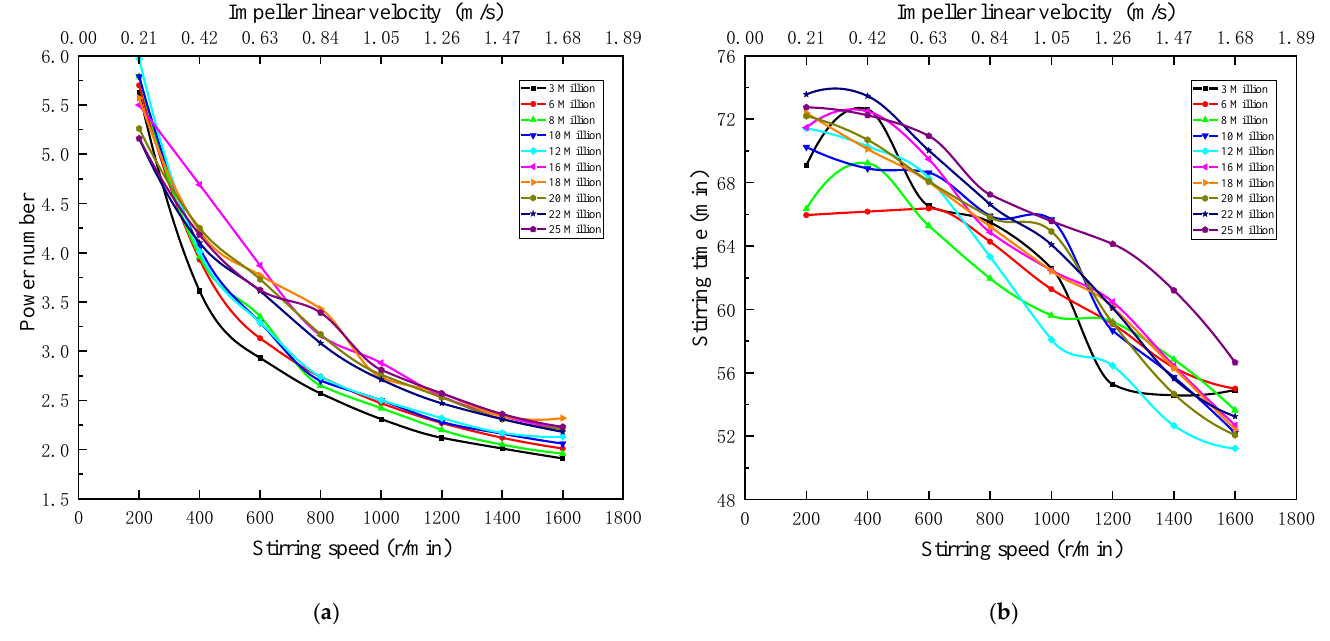
Figure 4. ( a ) Power number versus stirring speed; ( b ) Stirring time versus stirring speed.